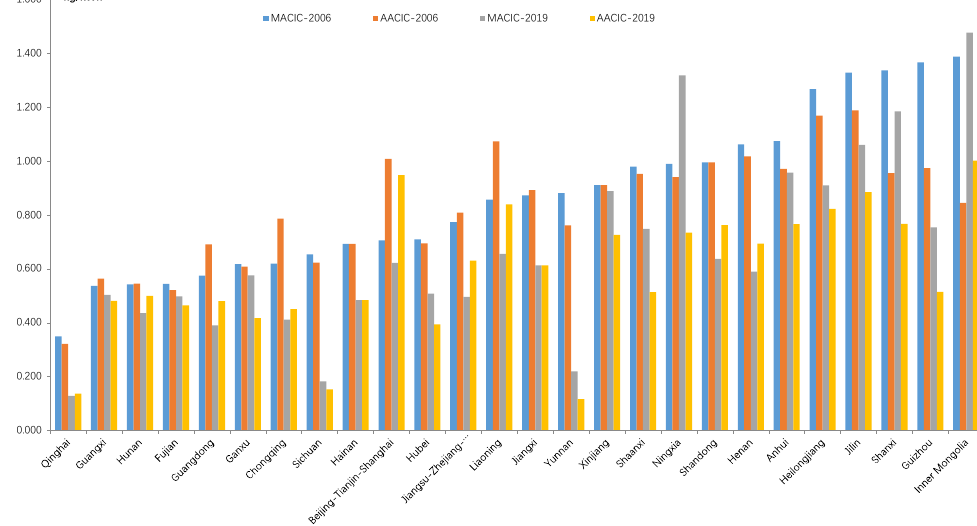
Figure 7. Comparison of ACIC values of consumption considering power transmission in 2006 and 2019 (No data for Tibet).